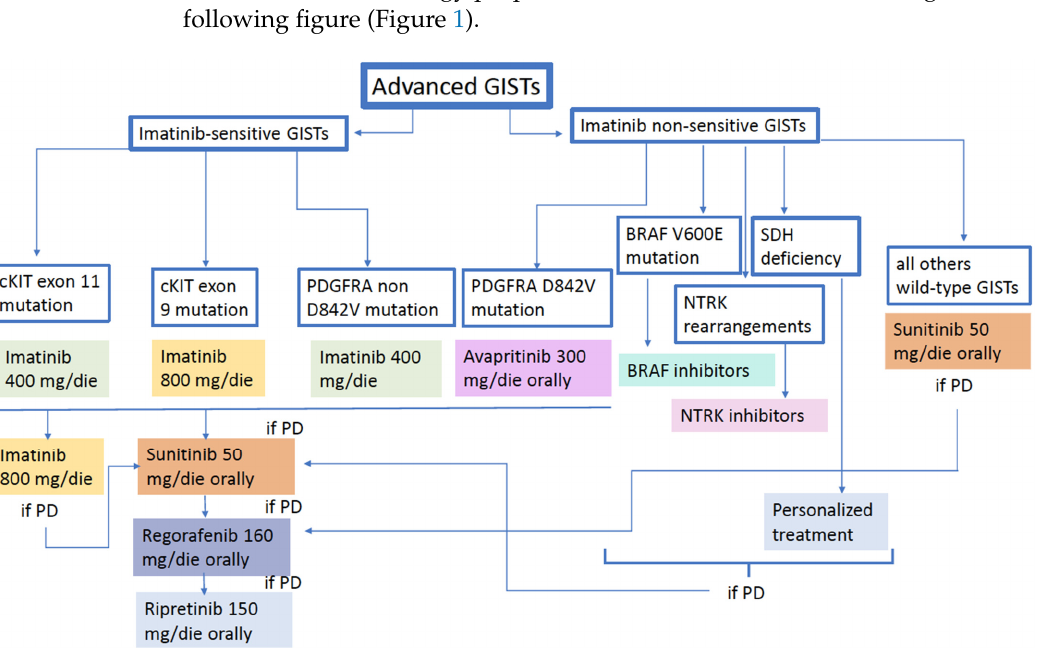
Figure 1 . GIST treatment algorithm. Figure 1. GIST treatment